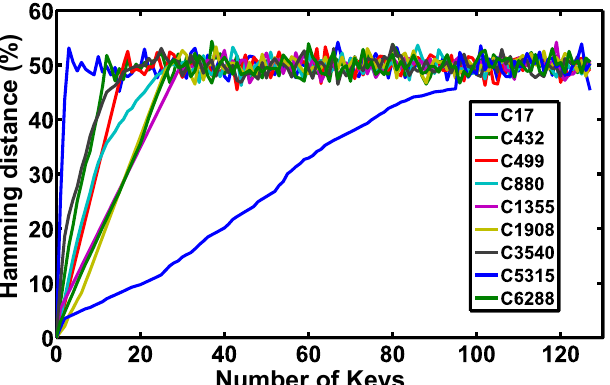
Figure 6. Hamming distance of ISCAS’85 (International Symposium on Circuits and Systems) benchmark circuits.